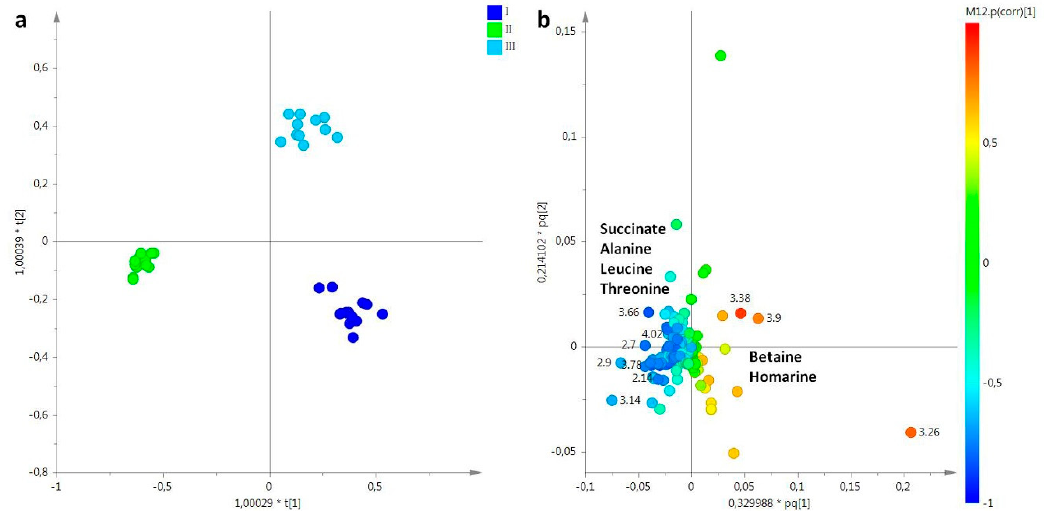
Figure 7. ( a ) OPLS-DA t[1] / t[2] scores plot of for aqueous extracts of female gonads of R. pulmo collected in different sampling periods: blue circle, March sampling (I); green circle, May sampling (II); sky blue circle, July sampling (III). ( b ) Loading plot for the model; the variables indicated ppm in the 1 H NMR spectrum.